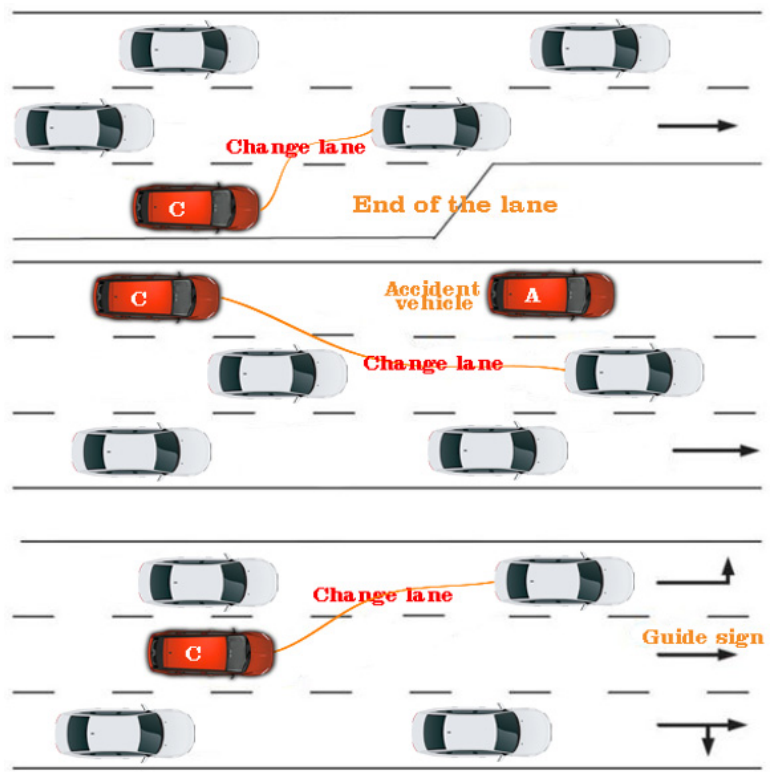
Figure 10. Illustration regarding the analysis and predictability model of urban traffic in conditions of increased density and accident or lane change.